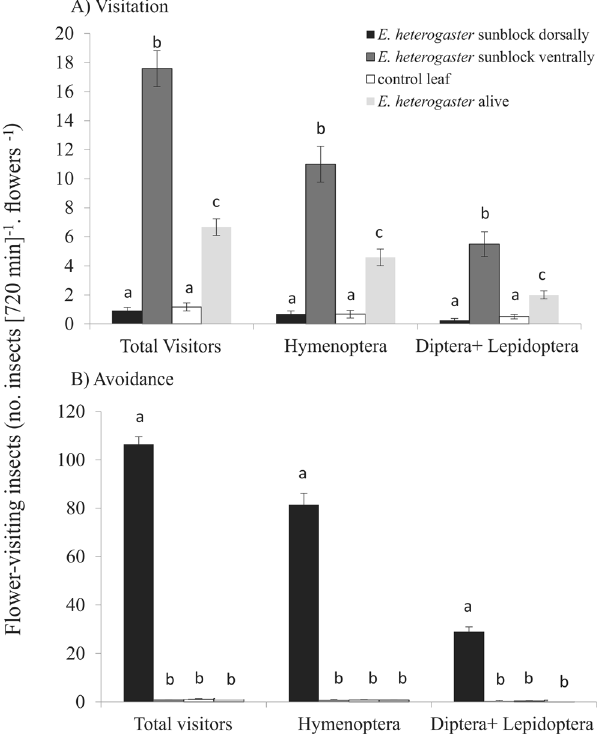
Figure 2. Statistical analysis of data from experiments of visitation and avoidance by pollinators. Mean number of ( A ) visits and ( B ) avoidance per 720 min of all pollinating insects (Total), as well as of Hymenoptera and Diptera + Lepidoptera on leaves. Leaves were assigned one of the following treatments: anesthetized spiders with sunscreen applied to the dorsal side, anesthetized spiders with sunscreen applied to the ventral side, unanesthetized spiders without sunscreen, and no spiders as controls. Error bars represent ± SE. Different letters indicate statistical difference ( P < 0.05; LME/Tukey HSD, post hoc test; α = 0.05).